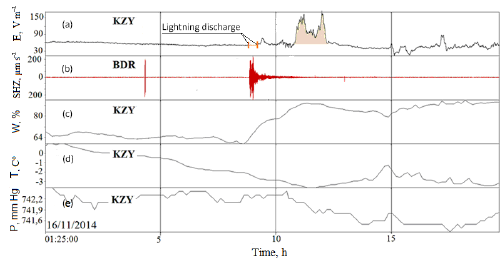
Figure 3. Electric field E at the KZY site (a) ; seismic signal SHZ (short period vertical component of seismic signal) at the BDR site accompanied the Shiveluch volcano eruption on 16 Novem- ber 2014 (b) ; meteorological parameters at the KZY site (c, d, e) . The beginning of the timescale is 01:25:00UT. The time interval of lightning activity is shown in (a)